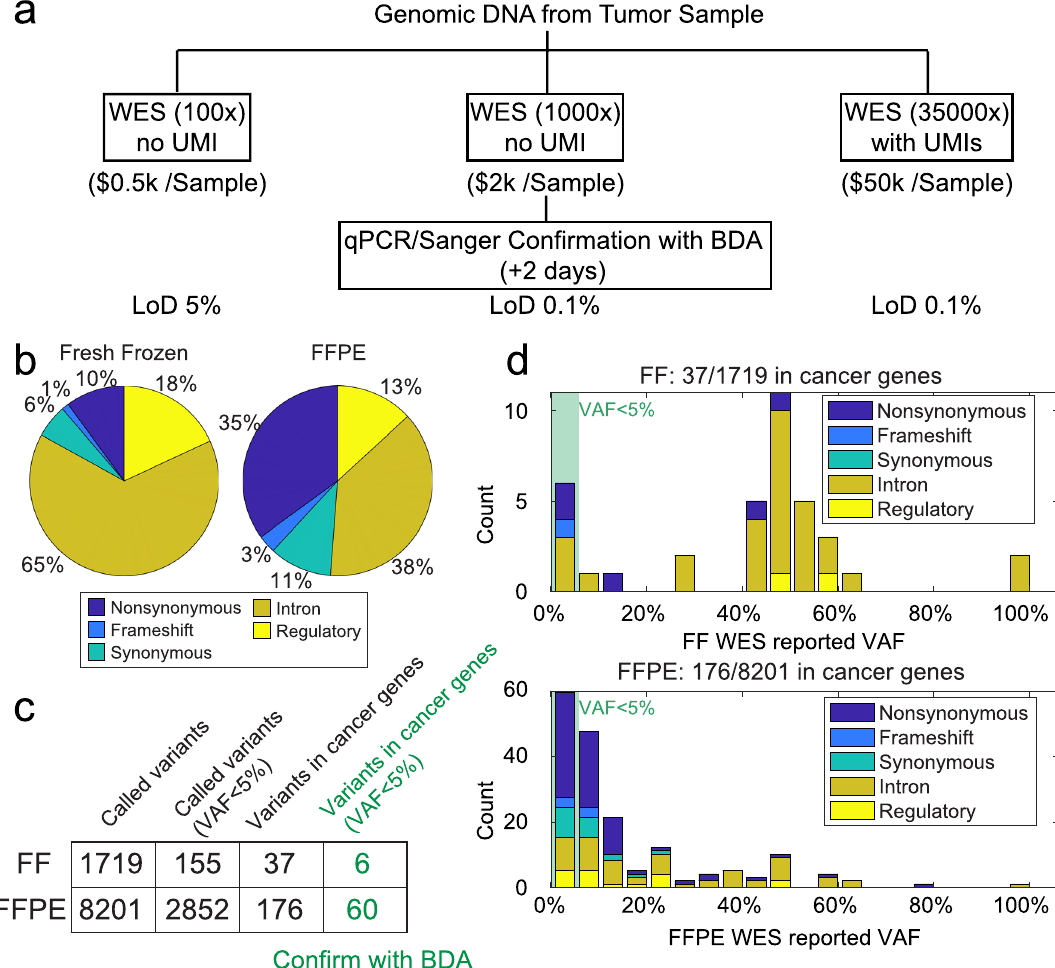
Figure 1. Somatic variant detection by whole exome sequencing of non-small cell lung cancer tumor samples. ( a ) Different depths of WES have different costs and LoDs. By incorporating BDA methodology, WES can achieve 0.1% VAF LoD at lower cost. ( b ) Categorical breakdown of WES detected somatic variants in the fresh- frozen (FF) sample (n = 1719) and the FFPE sample (n = 8201). ( c ) Number of somatic variants called by WES. All 66 variants with < 5% VAF and in cancer-related genes underwent confirmatory analysis by BDA. Another 160 variants with < 5% VAF but not in cancer-related genes also underwent confirmatory analysis by BDA. ( d ) VAF histogram and categorical breakdown of somatic variants detected in cancer-related